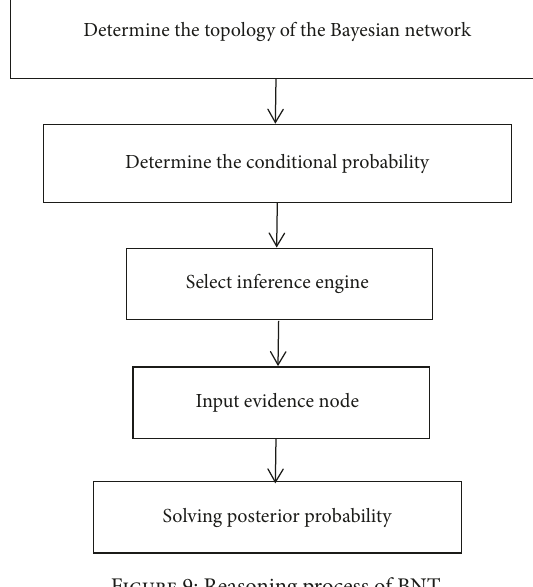
Figure 9: Reasoning process of BNT.